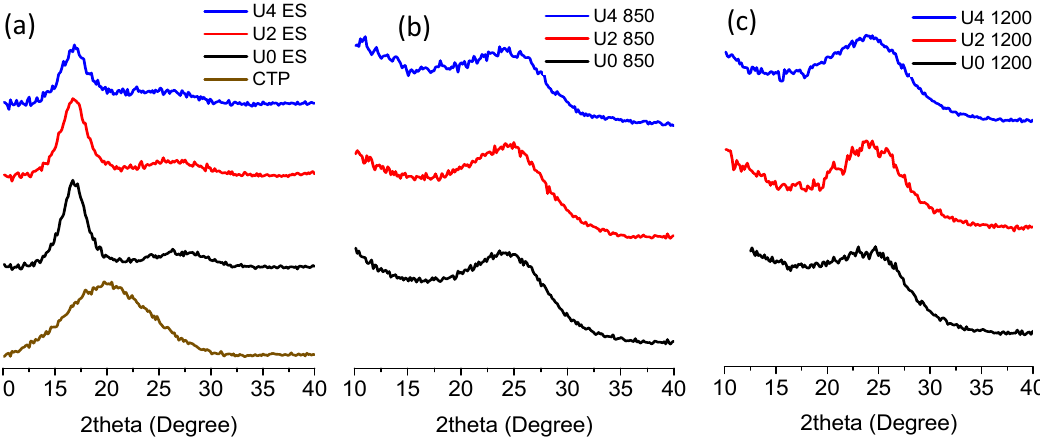
Figure 7. X-ray diffraction ( XRD) patterns of precursors ( a ), and carbonised fibre at 850 °C ( b ) and 850 °C ( c ) for U0, U2 and U4 samples. Table 4. The results extracted from XRD patterns and calculated size of crystallites for precursor, low temperature and high-temperature carbonised samples.